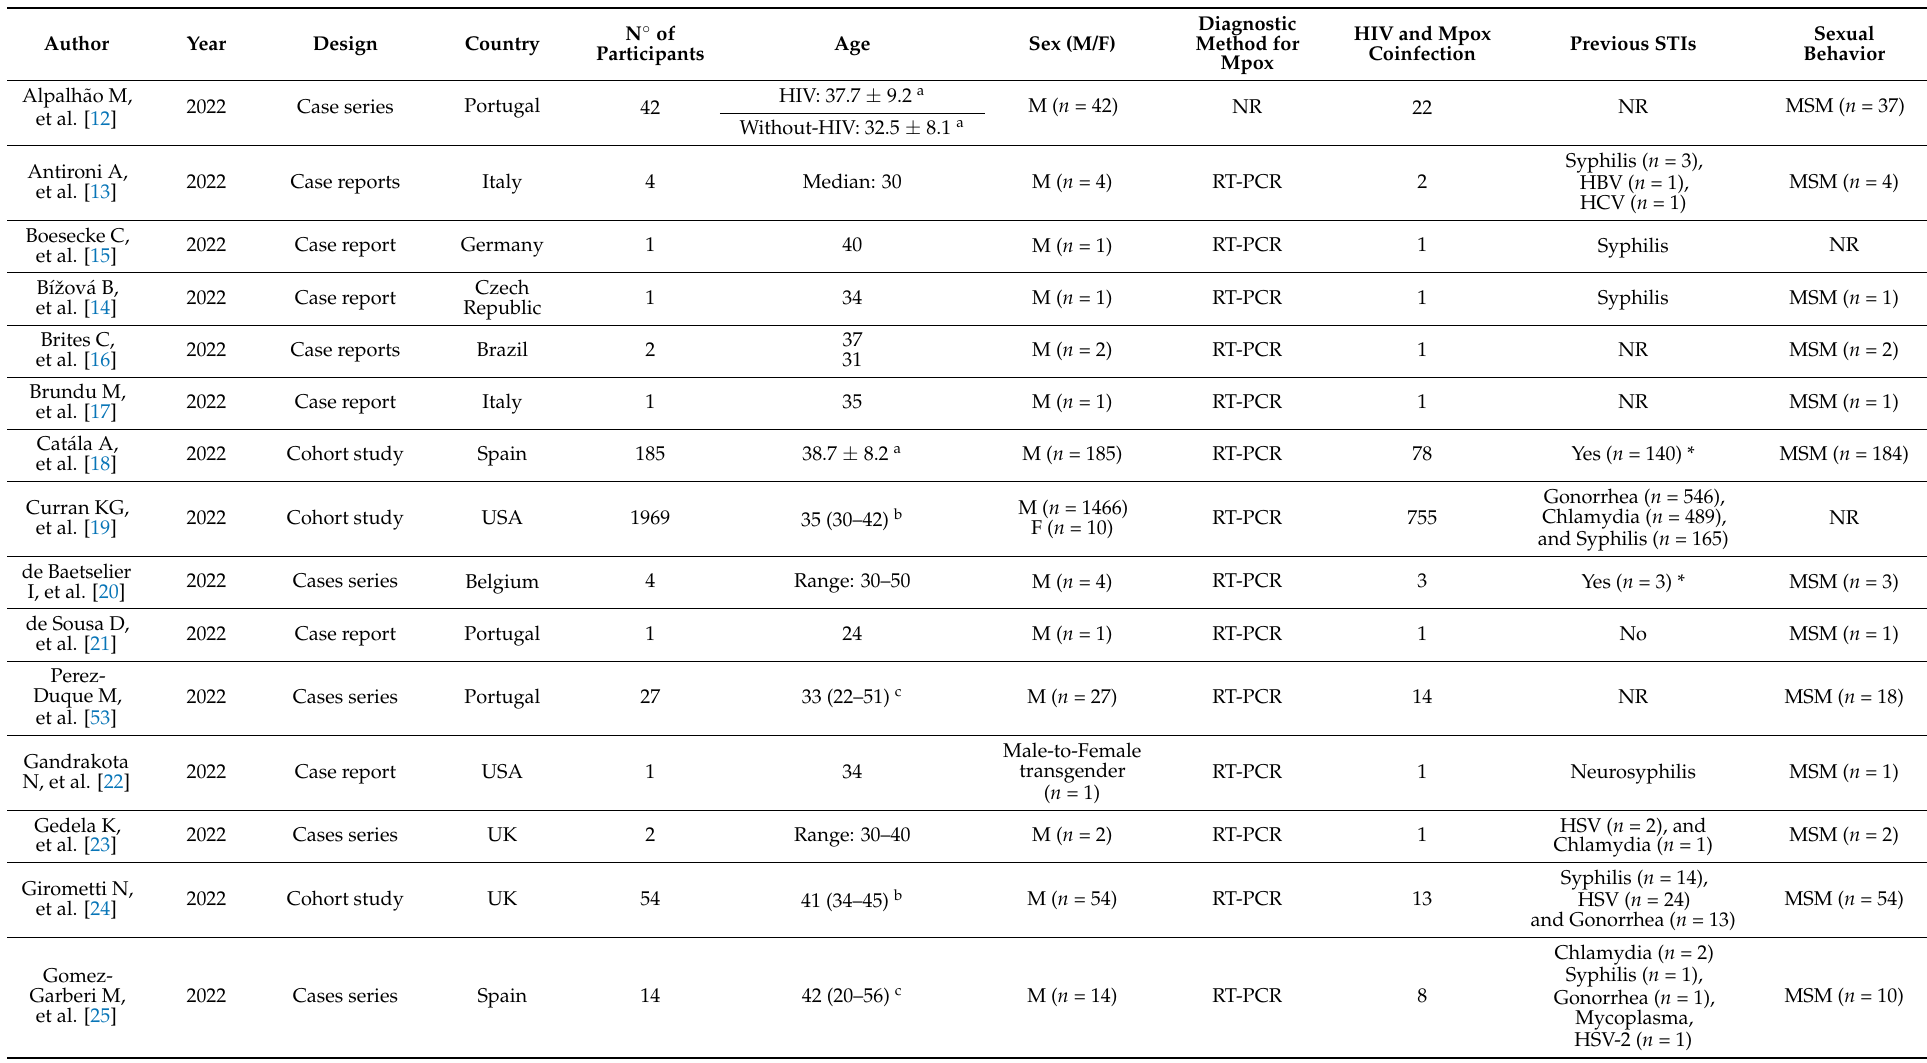
Table 2. Characteristics of included